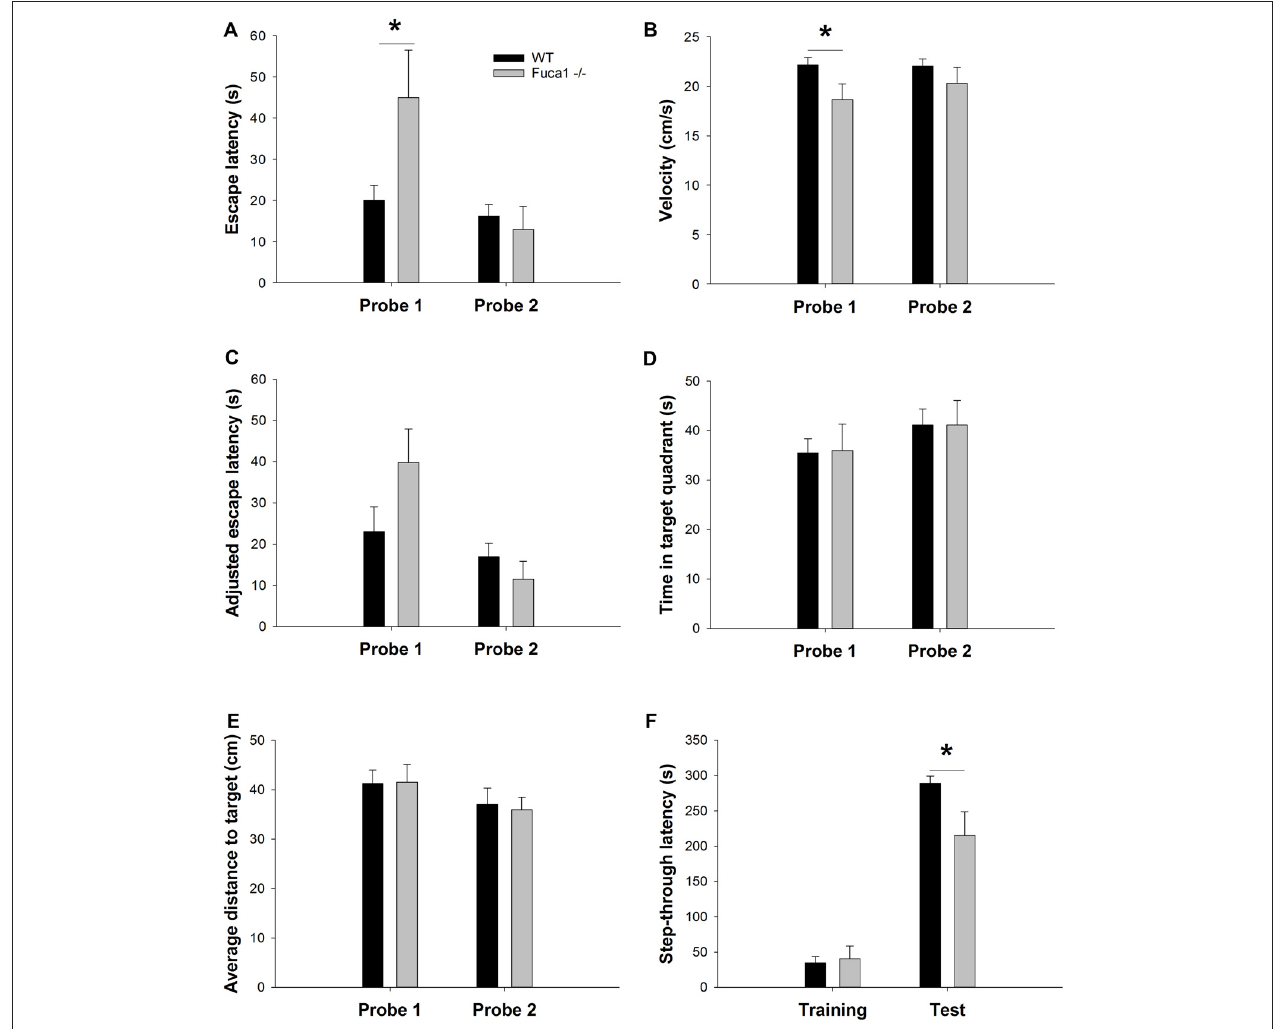
FIGURE 9 | Fuca1-deficient mice display intact spatial but impaired fear memory (A–E) . Probe trial performance in 3-month-old Fuca1-deficient mice (Fuca1 -/-, gray bars) and age-matched WT littermates (WT, black bars). Fuca1-deficient mice were slower to cross the virtual platform zone during the first probe trial (A) but also swam slower during this trial in comparison to WT littermates (B) . Virtual escape latencies were adjusted taking into account variability in swimming velocity, showing no residual differences (C) . Similar probe trial performance was further confirmed by other measures of spatial memory such as time spent in the target quadrant (D) and average distance to target (E) . Importantly, only sufficiently mobile animals were included for probe trial analysis (see “Materials and Methods” section final n: WT = 12, Fuca1 -/- = 7). (F) Passive avoidance learning in 3-month-old Fuca1-deficient mice (Fuca1 -/-, gray bars) and age-matched WT littermates (black bars). Step-through latencies of Fuca1-deficient mice did not differ from WT mice during the training phase. During contextual memory assessment 24 h later, both genotypes showed an increase of step-through latencies, indicating significant retention. However, Fuca1-deficient mice showed significantly reduced latencies in comparison to WT mice. Notably, three Fuca1-deficient mice were excluded from final analysis as they did not enter the dark compartment during the training trial (final n: WT = 15, Fuca1 -/- = 12). All data are presented as mean ± SEM. Asterisk indicates significance of